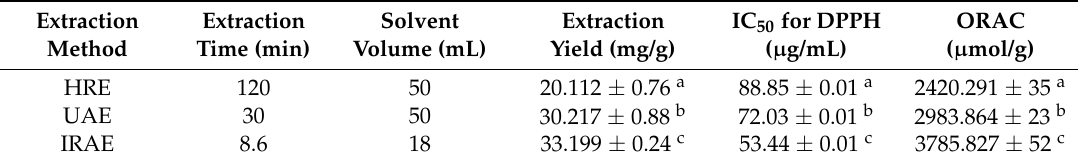
Table 6. Comparison of extraction yield and antioxidant activity among different methods. Extraction Extraction Method Time